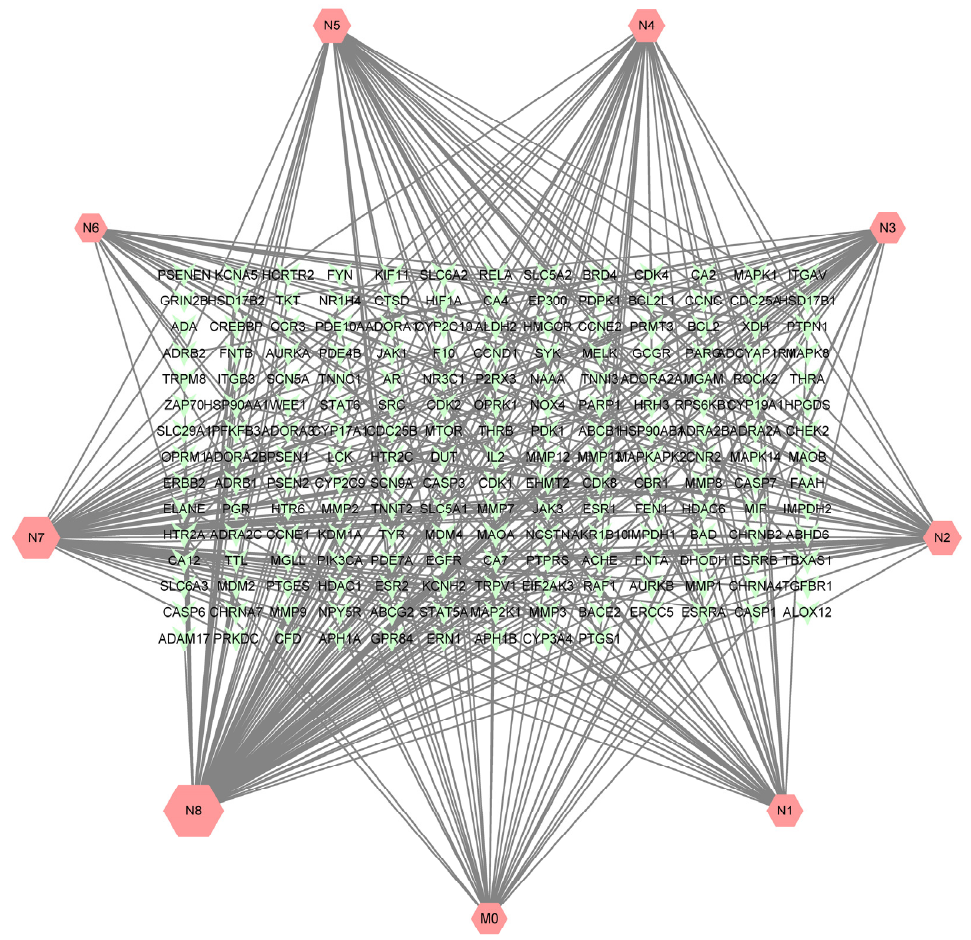
Figure 7. The ingredient-target network of neobavaisoflavone and its main metabolites, and the size was correlated to the degree of targets.